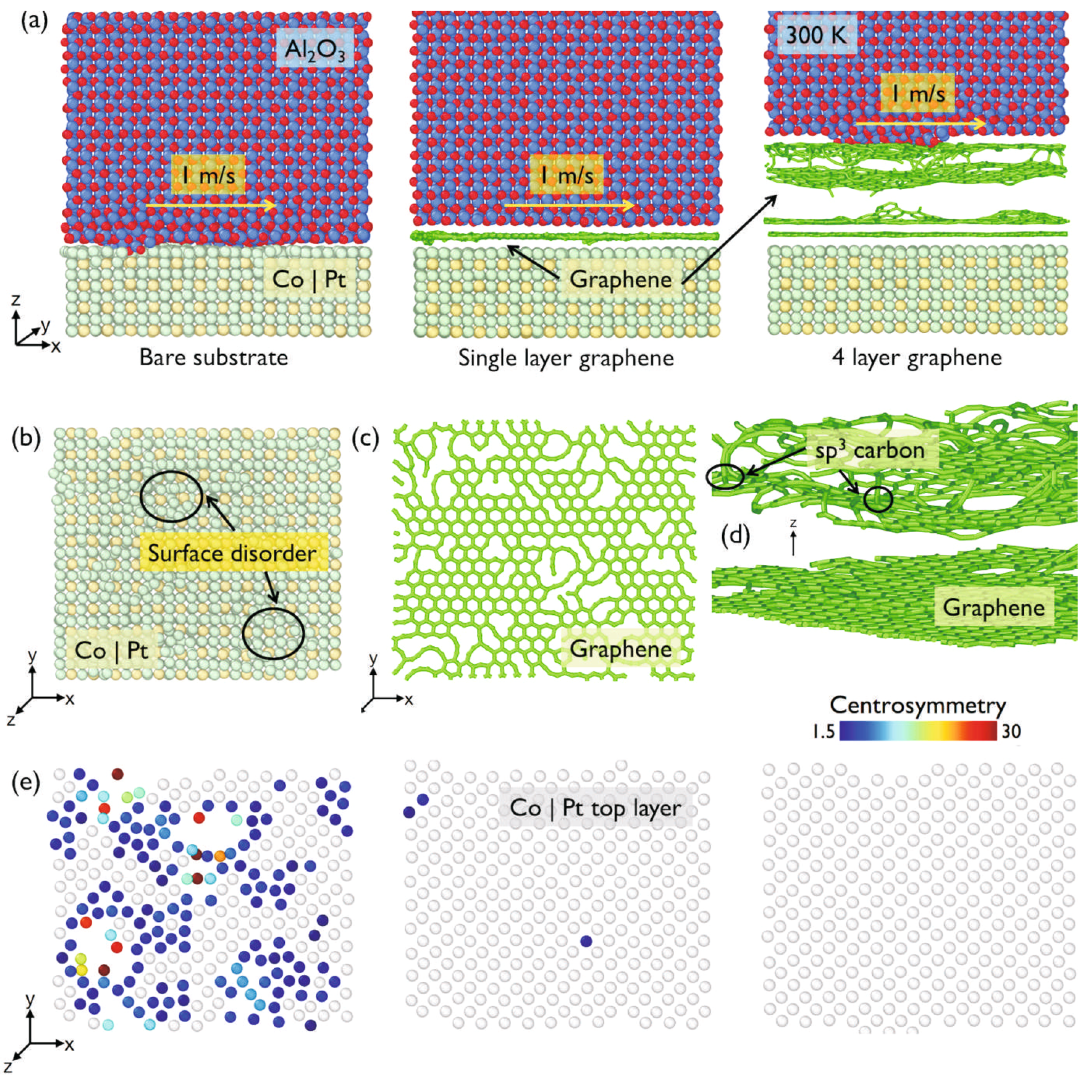
Fig. 10 Simulations of friction process. Light green spheres indicate Co ∣ Pt, red and blue spheres indicate Al 2 O 3 . a Simulation setup for evaluating wear between Al 2 O 3 and Co ∣ Pt. Simulations are performed for BM, 1, 4LG at 300 K, with materials sliding against each other at 1 m/s. b Interfacial surface atoms of bare Co ∣ Pt showing disorder. Two representative disorder regions are indicated by circles. c Structure of defected 1LG. d Structure of 4LG. The top two layers are attracted towards the Al 2 O 3 block with the formation of sp 3 cross-links. e Disorder of interfacial Co ∣ Pt surface using the centrosymmetry